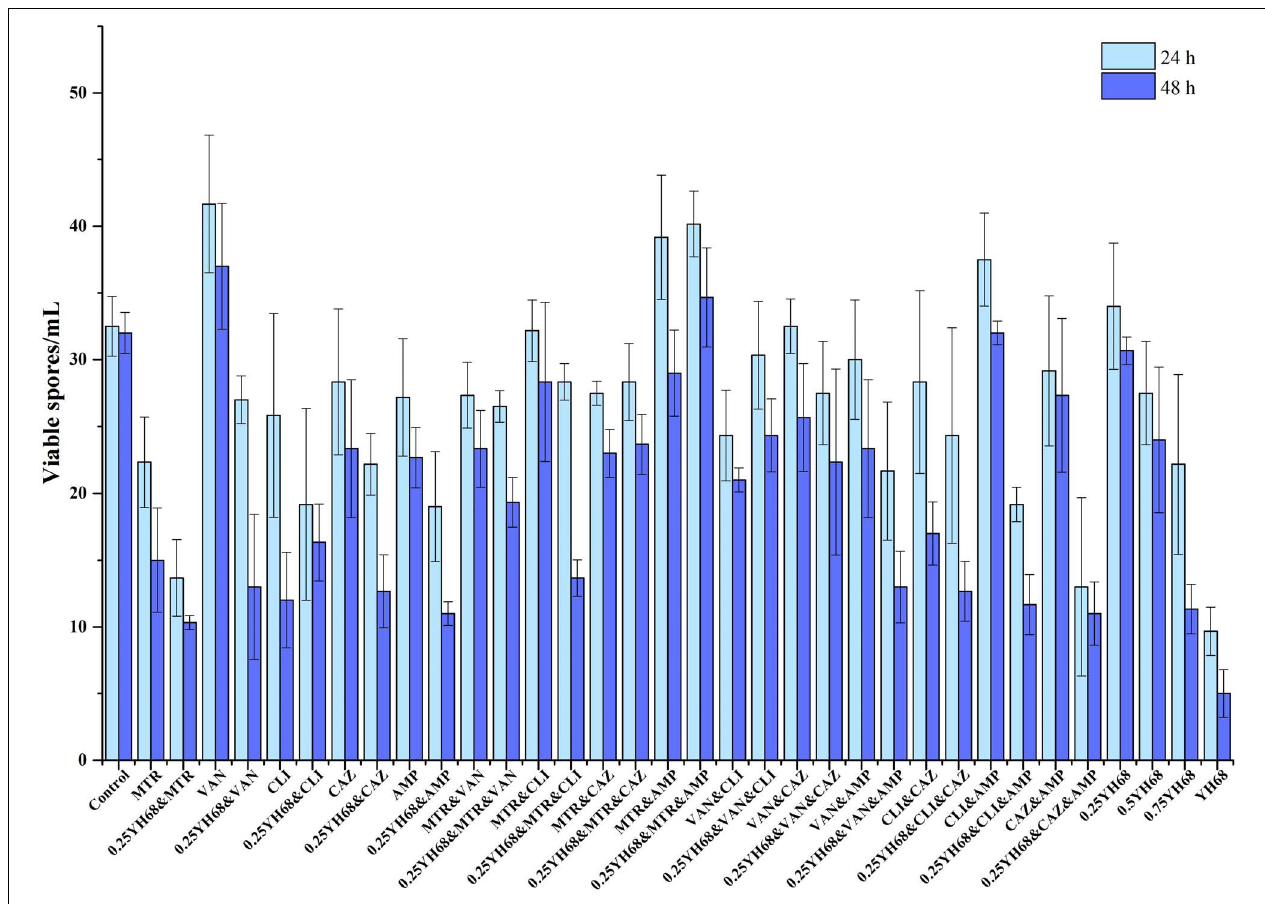
FIGURE 2 | Effects of different combinations on the spore production of C. difficile ATCC